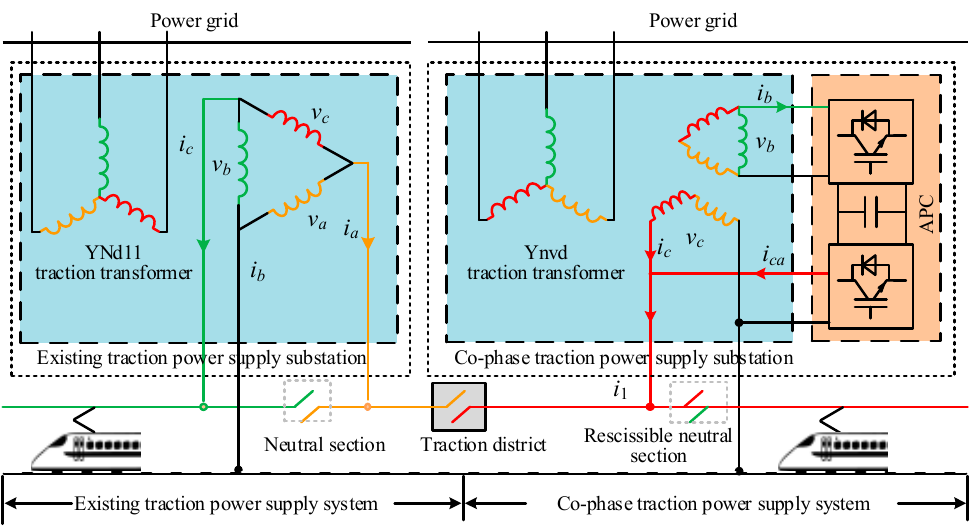
Figure 1. Traction power supply system. ( a ) The existing power supply substation, ( b ) the co-phase power supply substation based on active power compensators (APC).